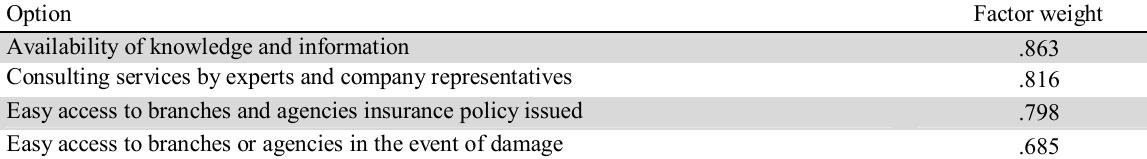
The summary of factors associated with quality of distribution channels Option Factor